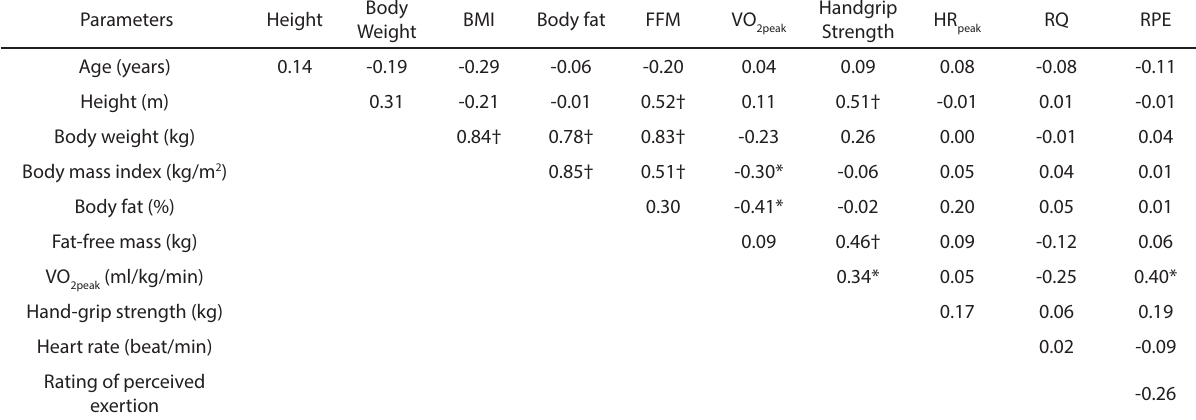
Table 2. Correlation Analysis Results among Handgrip Strength, Demographic Data, and Maximal Exercise Test Parameters